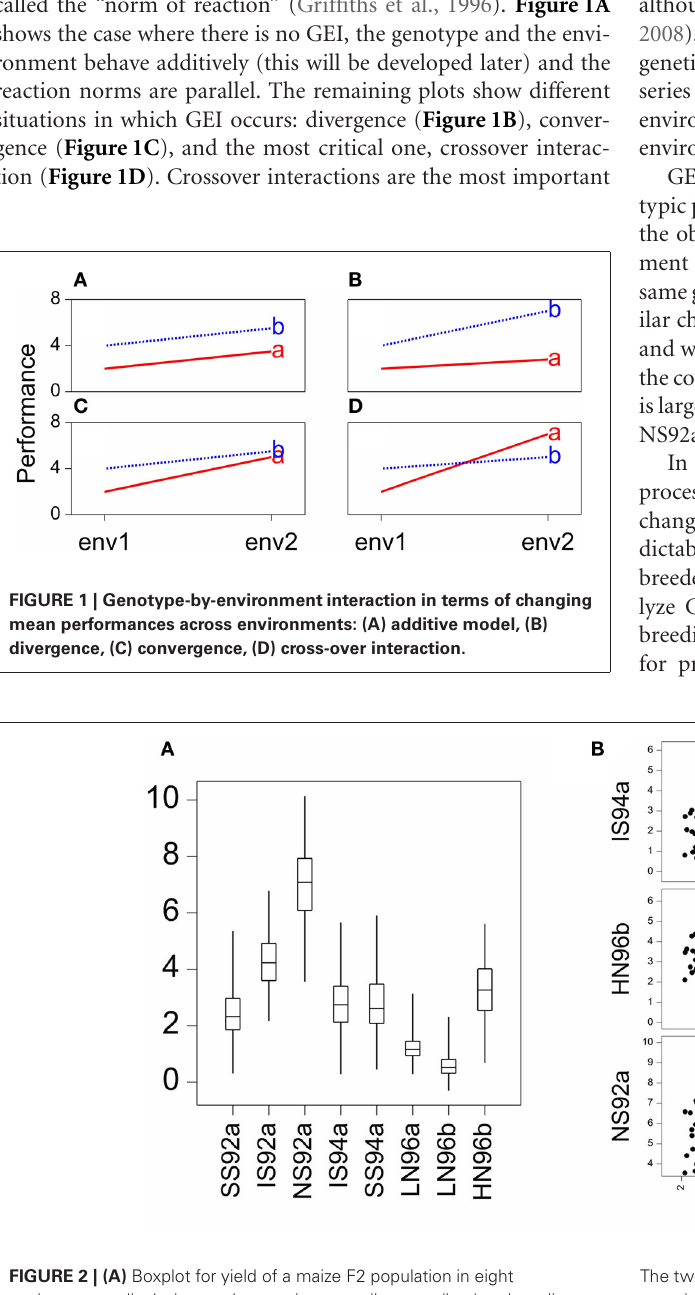
The two digits indicate the year of the trial, and the letters a and b the cropping season: a, winter; b, summer. (B) Scatter plot matrix for two stress environments (IS92a, and IS94a) and two non-stress environments (HN96b and